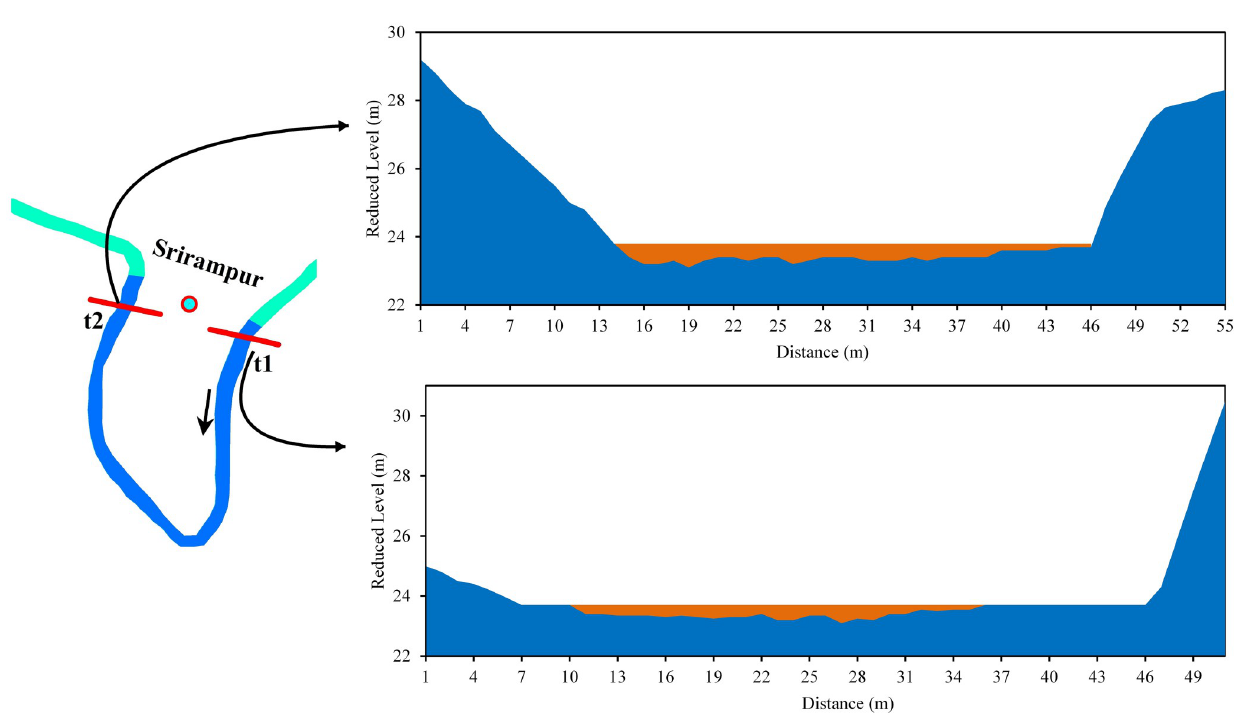
Fig 14. Cross-section across the Manu River at Srirampur (a) t1 (b) t2.